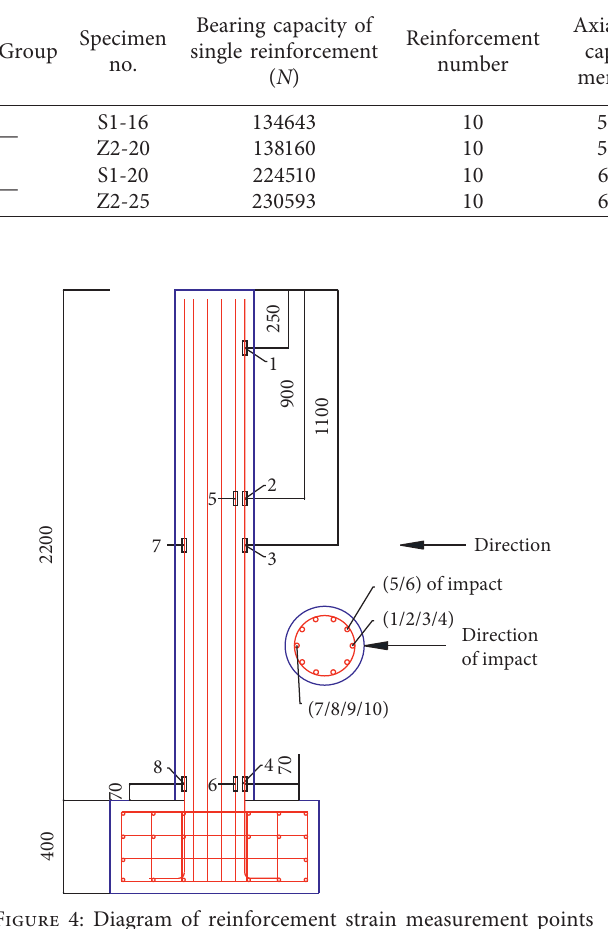
Figure 4: Diagram of reinforcement strain measurement points (unit: mm).